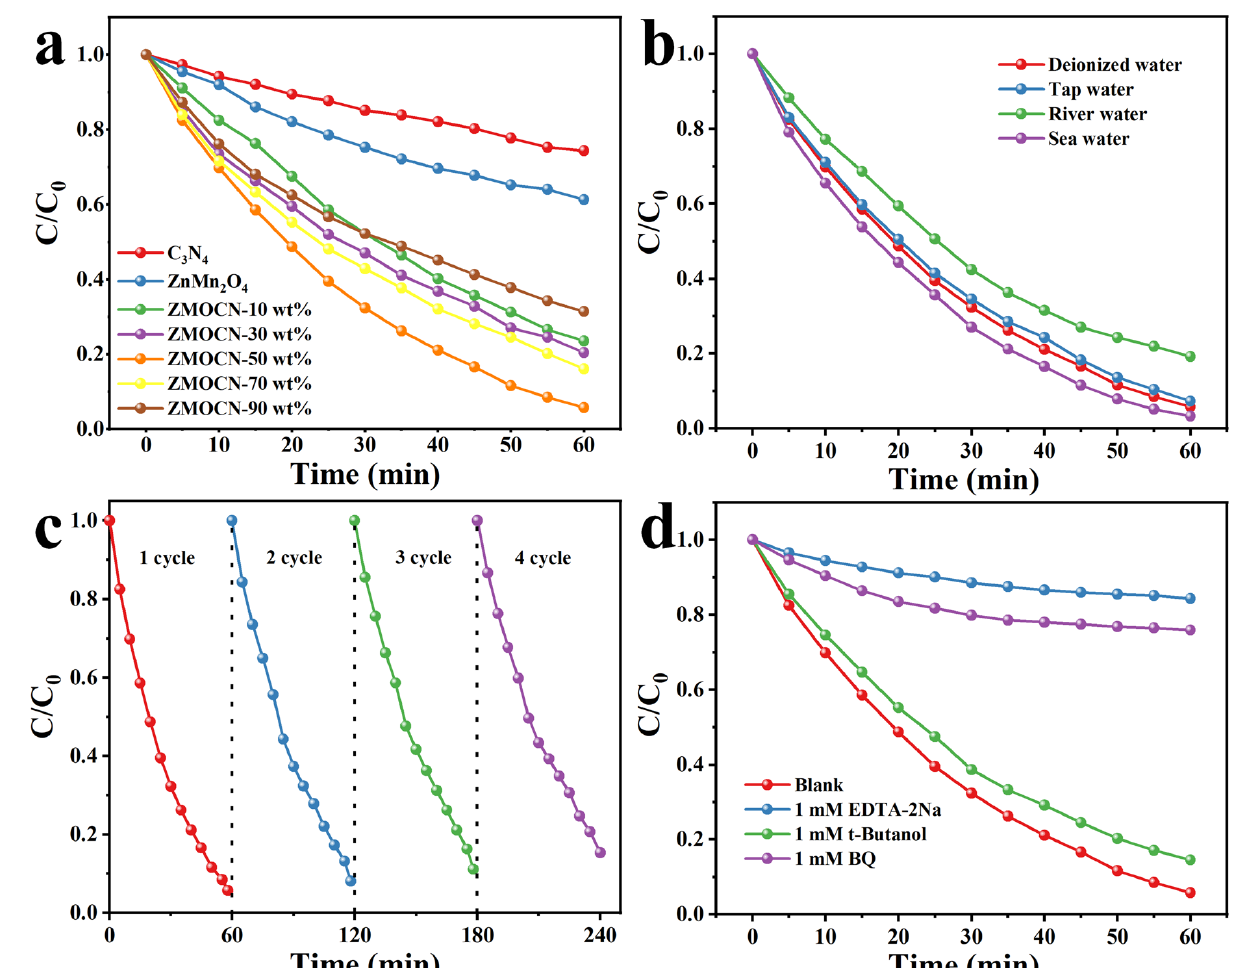
Figure 5. ( a ) photocatalytic degradation of SMX under simulated sunlight irradiation. ( b ) Photocatalytic degradation of SMX in different waters under simulated sunlight irradiation. ( c ) Degradation rate and stability. ( d ) Photocatalytic degradation efficiency of SMX over the ZMOCN-50 wt% with different quenchers.